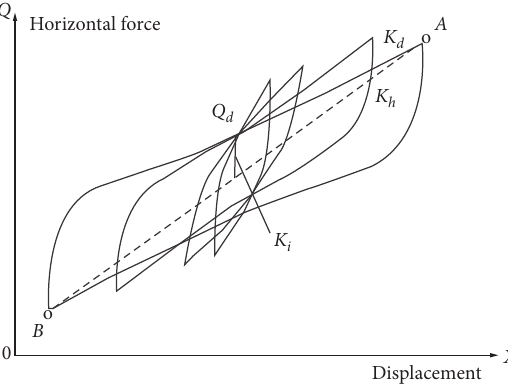
Figure 2: Shear performance curve of LRBs and